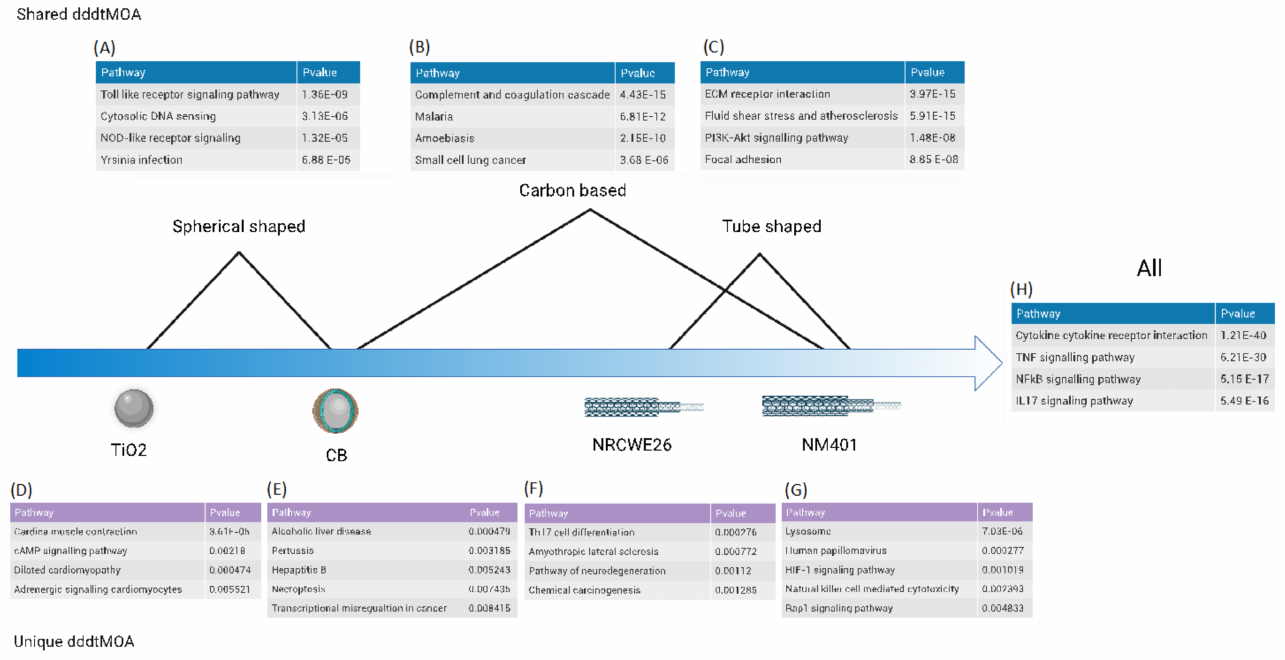
Figure 2. Functions of the dddtMOA shared across ENM categories ( A , B , C , H ) and specific to each ENM ( D , E , F , G